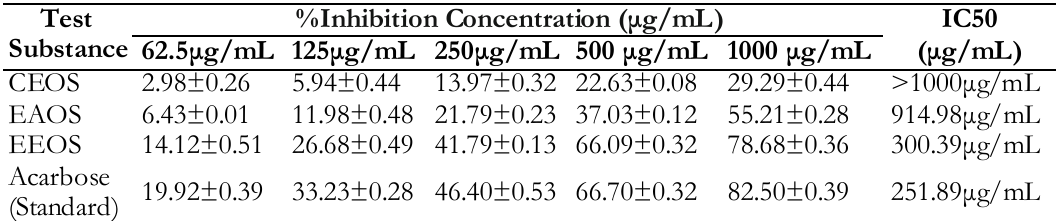
Table III . In vitro α-glucosidase inhibitory activity of Oncoba spinosa root extracts Test